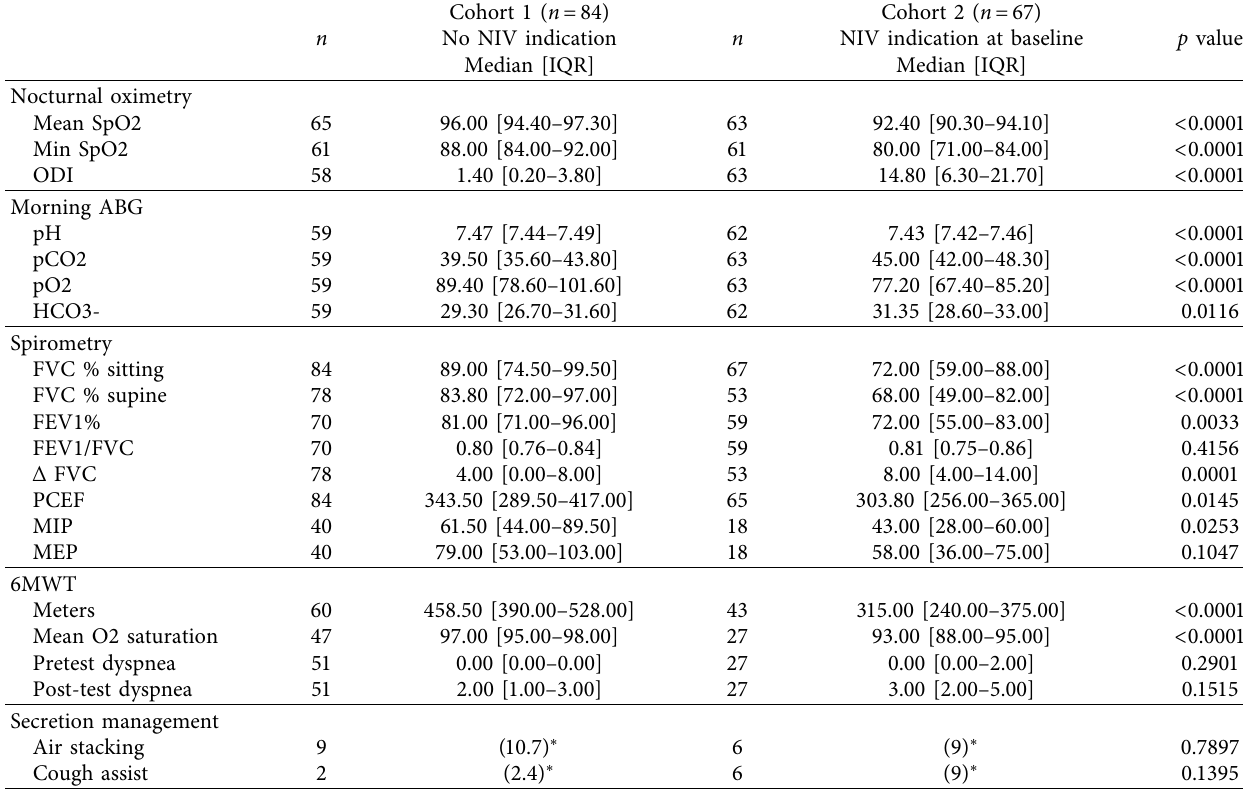
Table 4: Detailed respiratory features of the 2 cohorts according to NIV